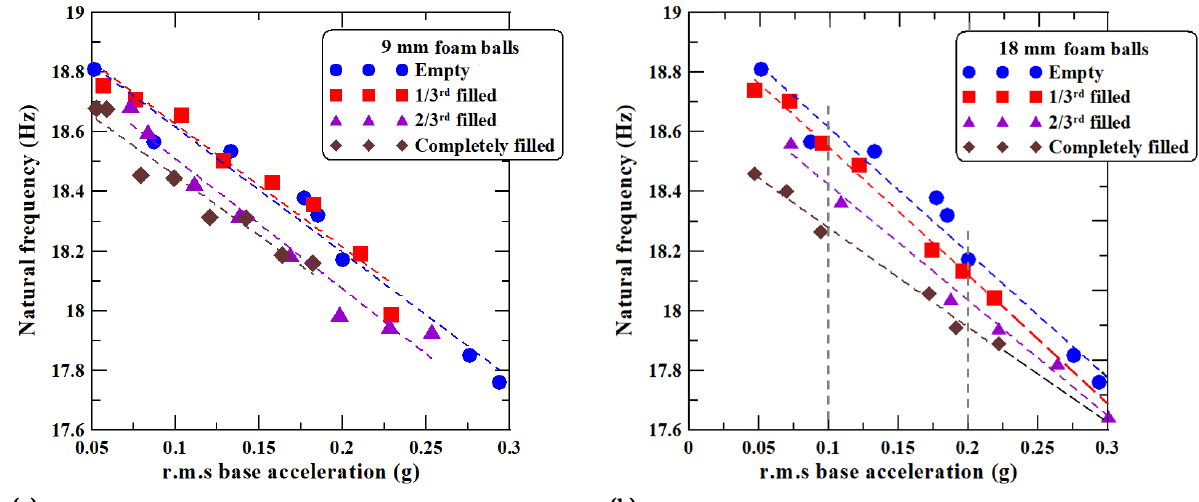
Figure 7: Fundamental frequency of foam filled tubes with: (a) 9 mm and (b) 18 mm diameter